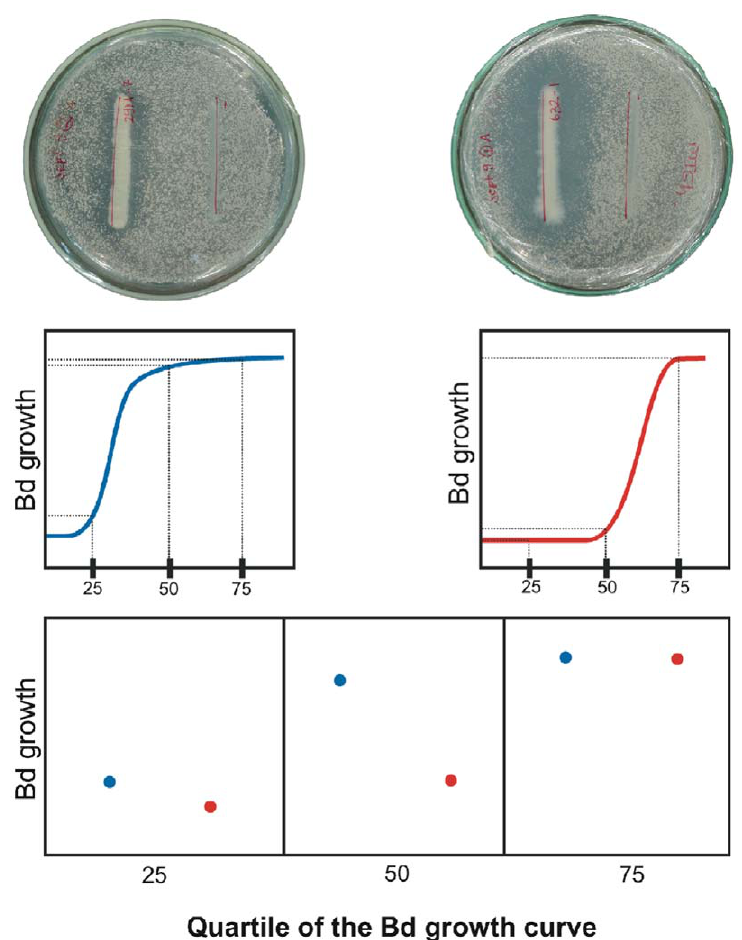
Figure 1. Photometric method. Estimation of bacterial anti- Bd effect as a combined measurement of the inhibition halo around the query bacteria (thick width band, above) and the decreasing density of Bd colonies. A spline regression model is fitted to grey values (i.e. density of Bd colonies) against distance to the query bacteria (middle). Bd growth is then interpolated at the first (25), second (50), and third (75) quartiles (middle and below). The bacterial isolate in the right column (red) have a stronger anti- Bd effect than the bacteria in the left column (blue).